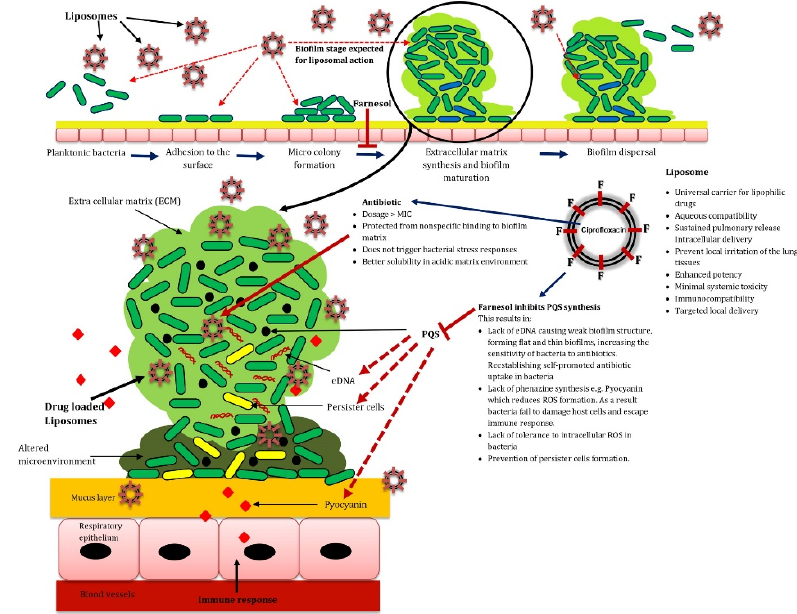
Figure 4. Proposed mechanism explaining the P. aeruginosa biofilm disruption by liposomes loaded with farnesol and ciprofloxacin [80]. Reprinted with permission from (Mol. Pharmaceutics). Copyright